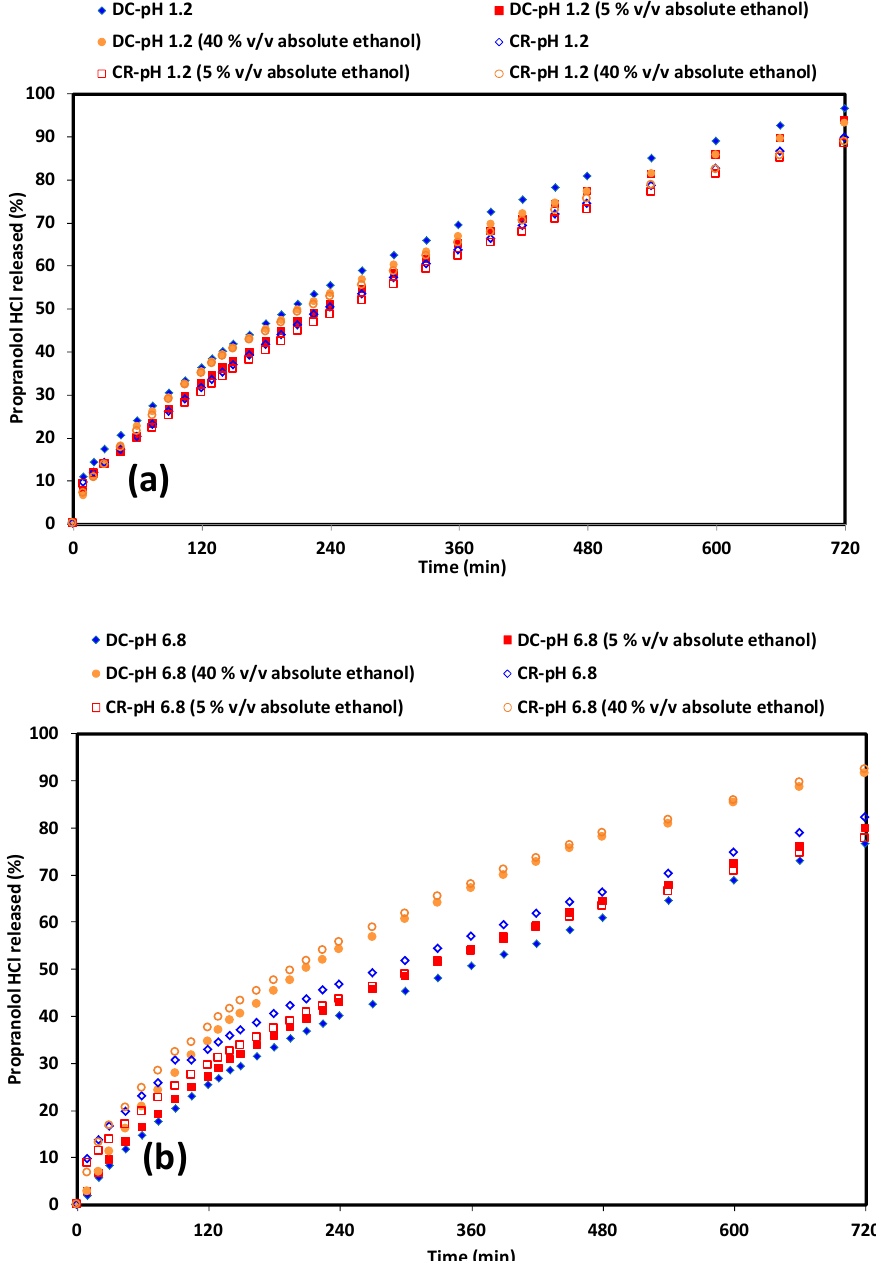
Figure 10. PPN release from CR and DC compacts ( a ) at pH 1.2 with differing alcoholic content, ( b ) at pH 6.8 with differing alcoholic content.